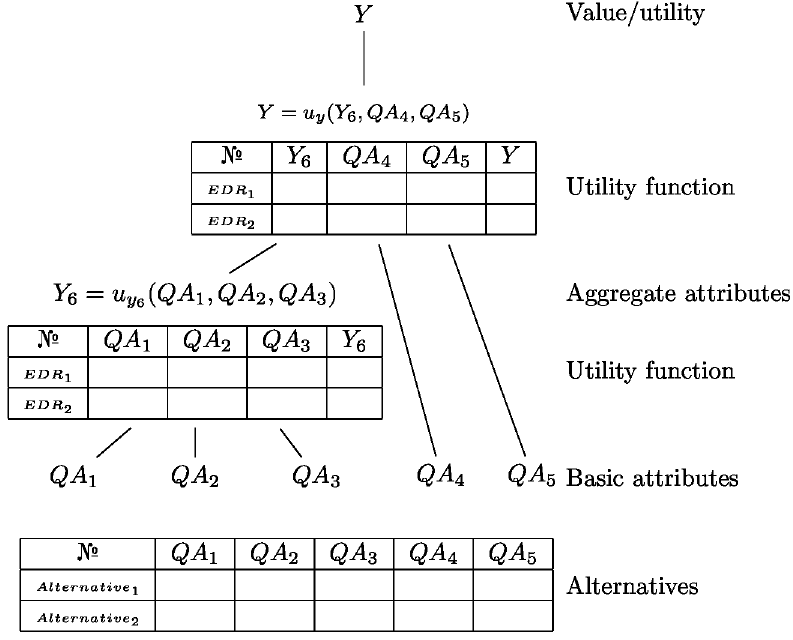
Fig 1. Hierarchical DEX model tree.